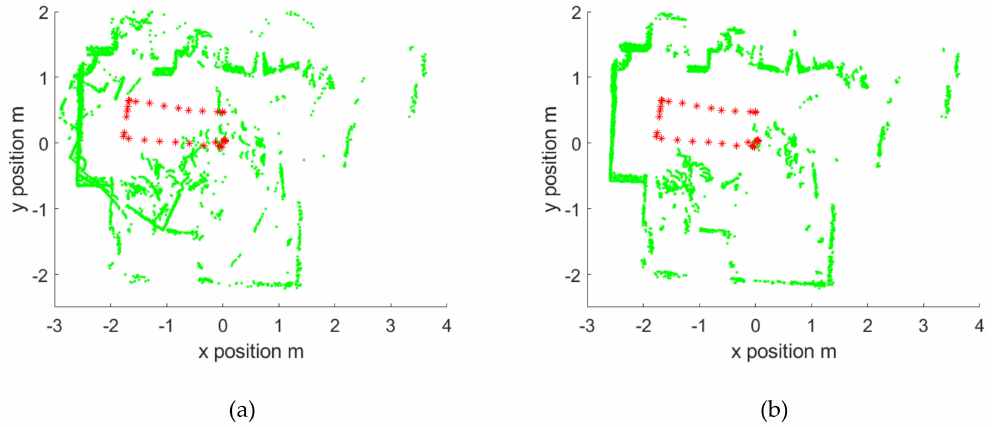
Figure 12. The generated maps using NDT ( a ) and the proposed FFT-ICP2 method ( b ). The red stars represent the real locations of the